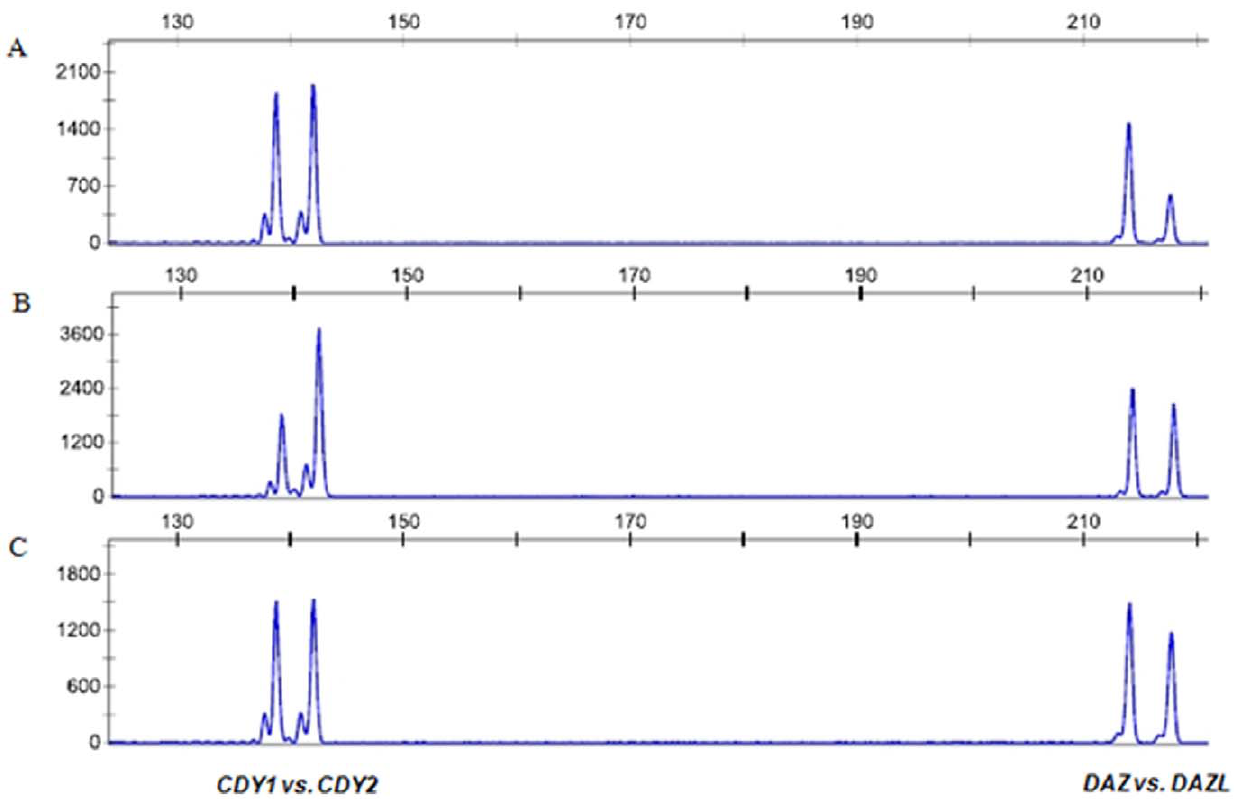
Figure 3. Examples of electrophoretograms showing different gene dosages of CDY 1/ CDY 2 and DAZ / DAZL genes. The x -axis shows length of PCR products in base pairs and y-axis shows fluorescent intensity. The gene dosage of CDY 1 and DAZ can be calculated by the comparison of peak area with CDY 2 and DAZL , respectively, as internal standard with known number of copies. (A) Gene dosage of CDY 1 and DAZ showed the 1:1 of CDY 1/ CDY 2 and 2:1 of DAZ / DAZL patterns (in cases of no deletion according to the reference sequence or gr/gr deletion-b2/b4 duplication) (B) Gene dosage of CDY 1 and DAZ identified by the 0.5:1 of CDY 1/ CDY 2 and 1:1 of DAZ / DAZL patterns (in case of gr/gr deletion) (C) Gene dosage of CDY 1 and DAZ identified by the 1:1 of CDY 1/ CDY 2 and 1:1 of DAZ / DAZL patterns (in case of gr/gr deletion- CDY 1 amplification).